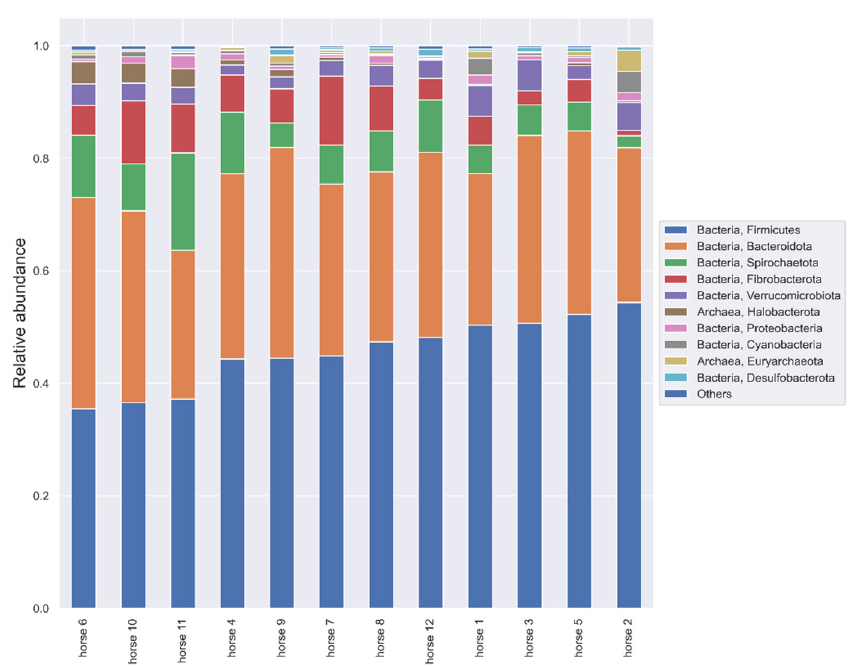
Figure 4. Relative abundance of microbiota from horse feces at the phylum level. Taxonomy based on V7–V9 hypervariable region of 16S rRNA gene. Phyla whose relative abundance accounts for less than 0.01 are found in Others.